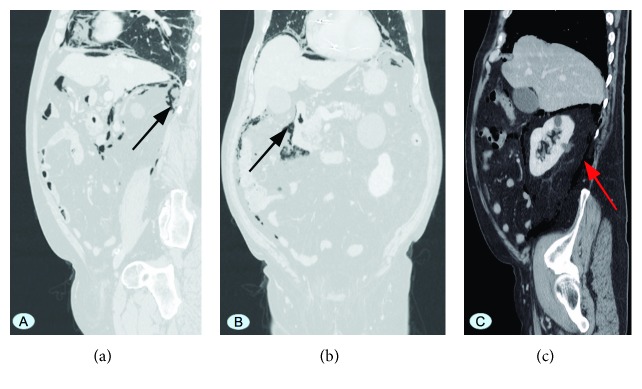
Abdominal CT scan showing pneumoperitoneum and pneumoretroperitoneum (a, b), mainly located at the epimesogastrium, at the right anterior and posterior pararenal and perihepatic spaces (c) (black arrows, red arrow).